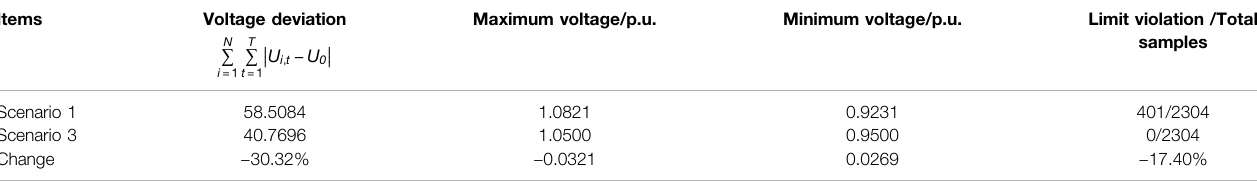
TABLE 3 | Overall characteristics of node voltage in Scenarios 1 and 3. Items